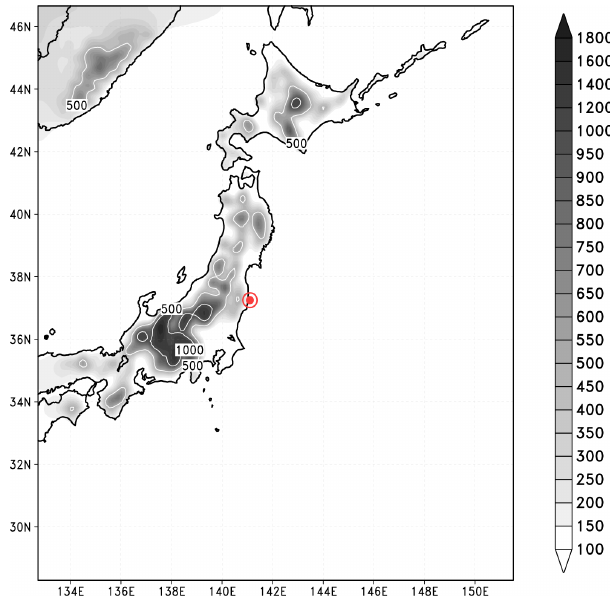
Figure 5. Experimental domain for the case study. The shaded val- ues indicate orography (m). The red circle is the emission point, which is the location of the nuclear power plant in